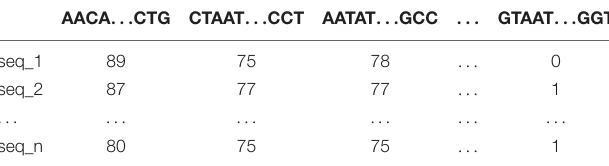
TABLE 1 | Example of the output count table produced by the